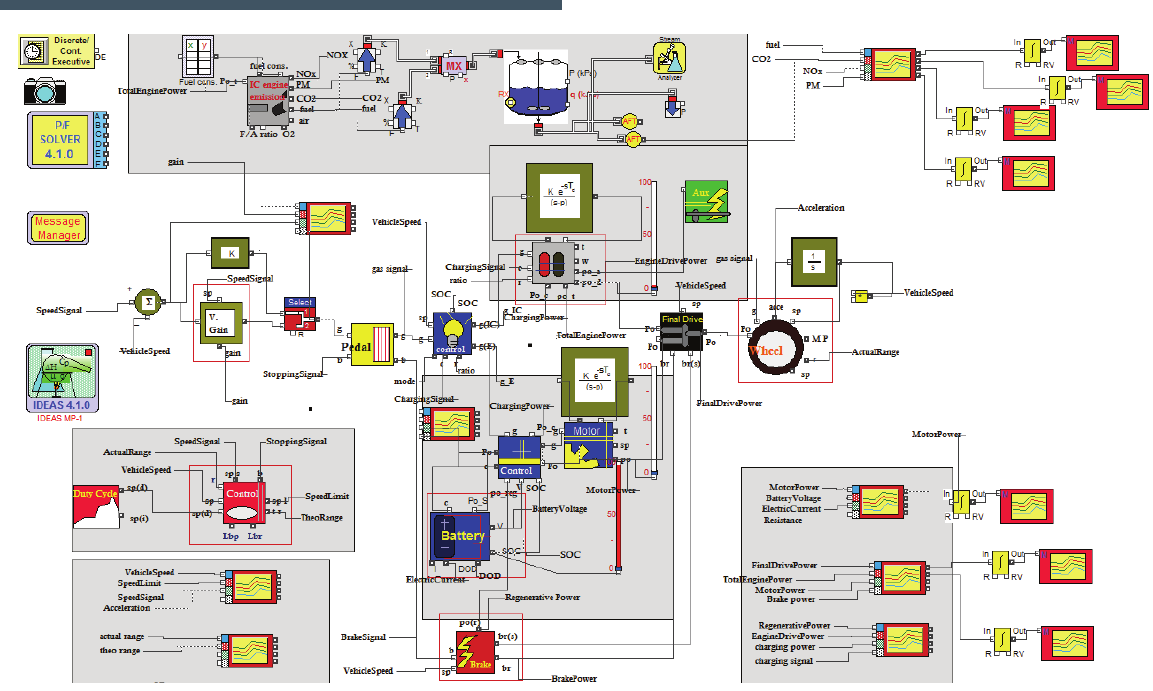
Figure 2. Layout of the PHEV library.